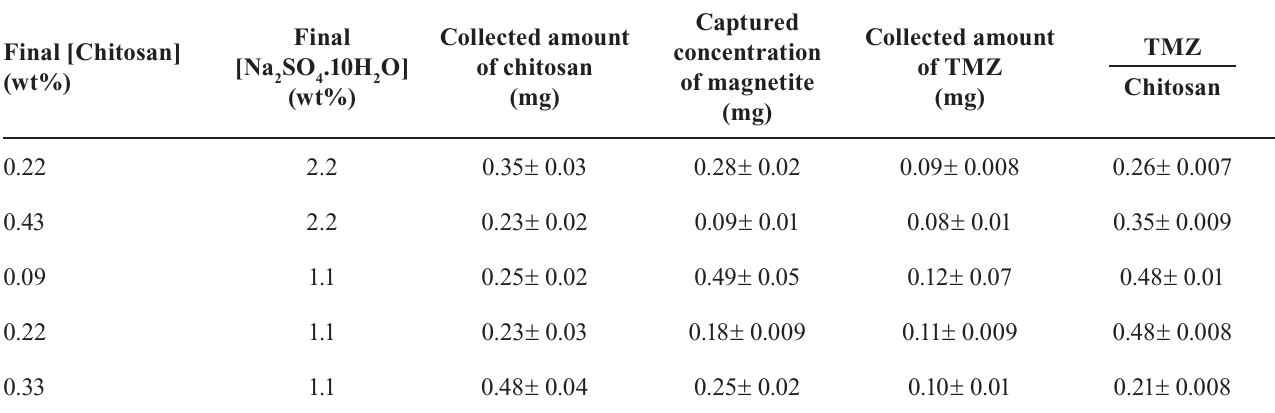
TABLE III - Targeting study with Section I (applying 0.3 T magnetic